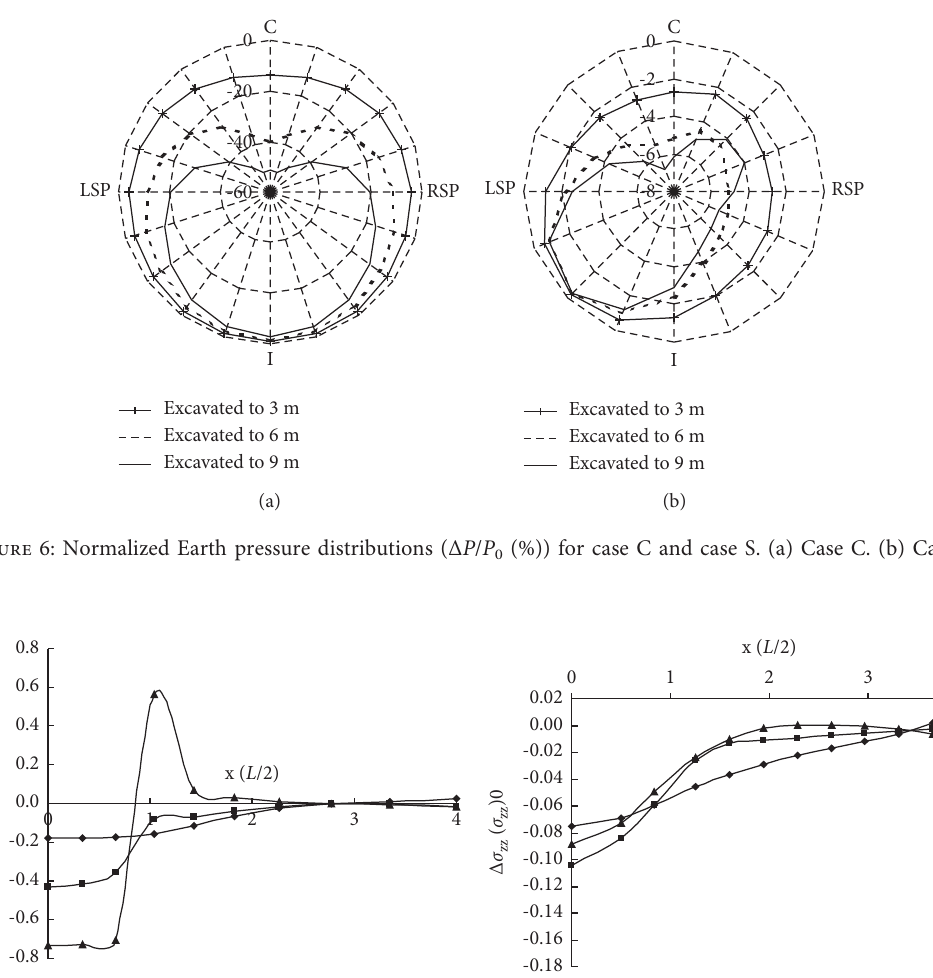
Figure 7: Changes in normalized vertical stresses along tunnel axis in case C and case S. (a) Case C and (b) case S. Soil elements: C, crown; SP, left spring line or right spring line in case C, right spring line in case S; and I,